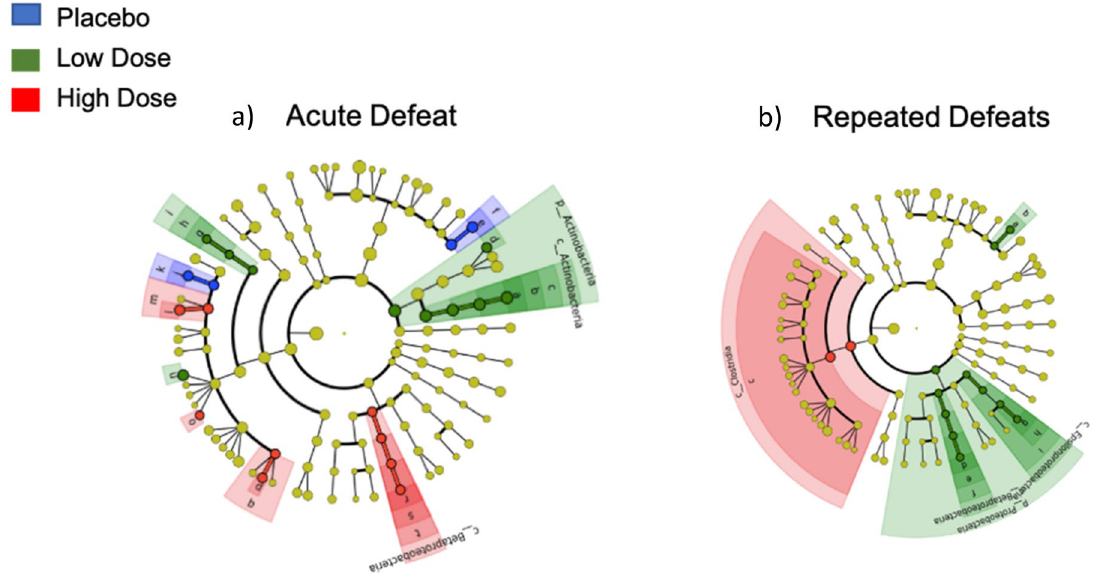
Figure 5. Identification of microbial taxa that were differentially altered across groups following acute or repeated social defeat. LEfSE analysis (Version 1, available at: https ://hutte nhowe r.sph.harva rd.edu/galax y/)) 82 was used to identify microbial taxa that differed among or between groups in hamsters given either a low dose of the probiotic (green), high dose of the probiotic (red), or placebo (blue) after an acute defeat ( a ) or repeated defeats ( b ). Blue represents taxa higher in placebo-treated hamsters compared to both doses of the probiotic; green, taxa higher in hamsters treated with a low dose of the probiotic compared to the high dose or placebo; red, taxa higher in hamsters treated with a high dose of the probiotic compared to the low dose or placebo. Only taxa meeting an LDA significant threshold of > 2.0 are